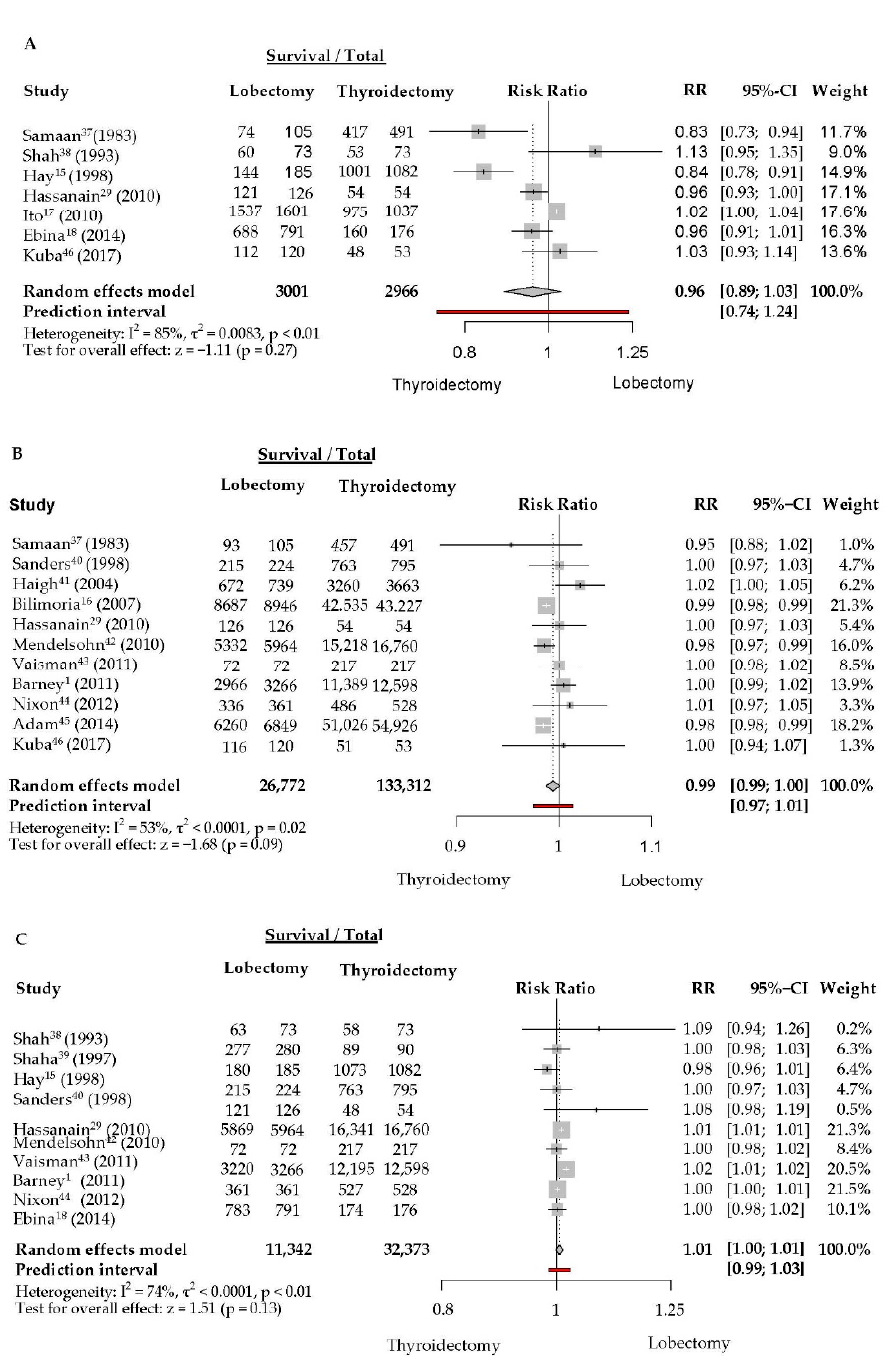
Figure 3. Survival rates of thyroid carcinoma after total thyroidectomy versus lobectomy. ( A ) DFS; ( B ) OS; ( C ) DSS.